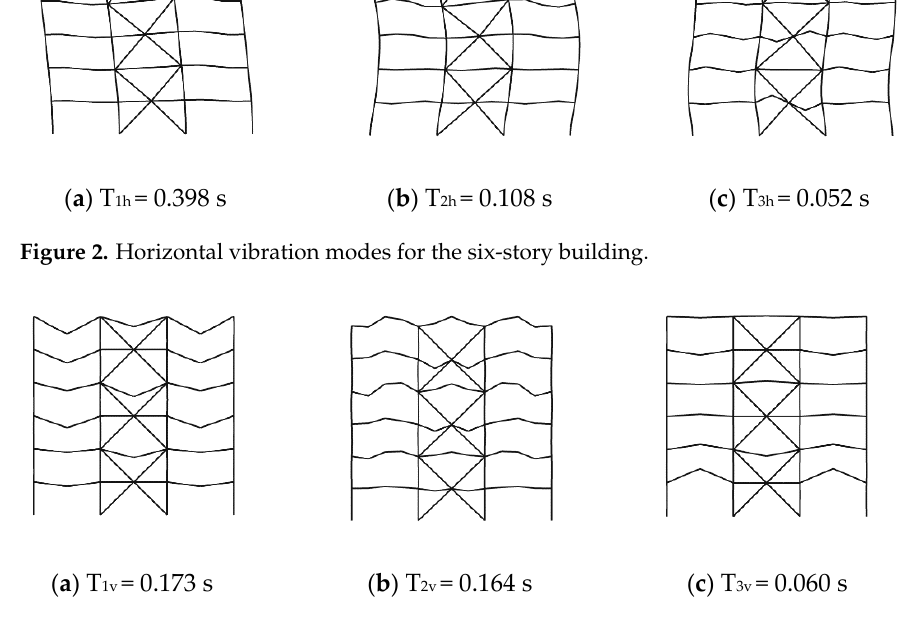
Figure 2. Horizontal vibration modes for the six-story building.